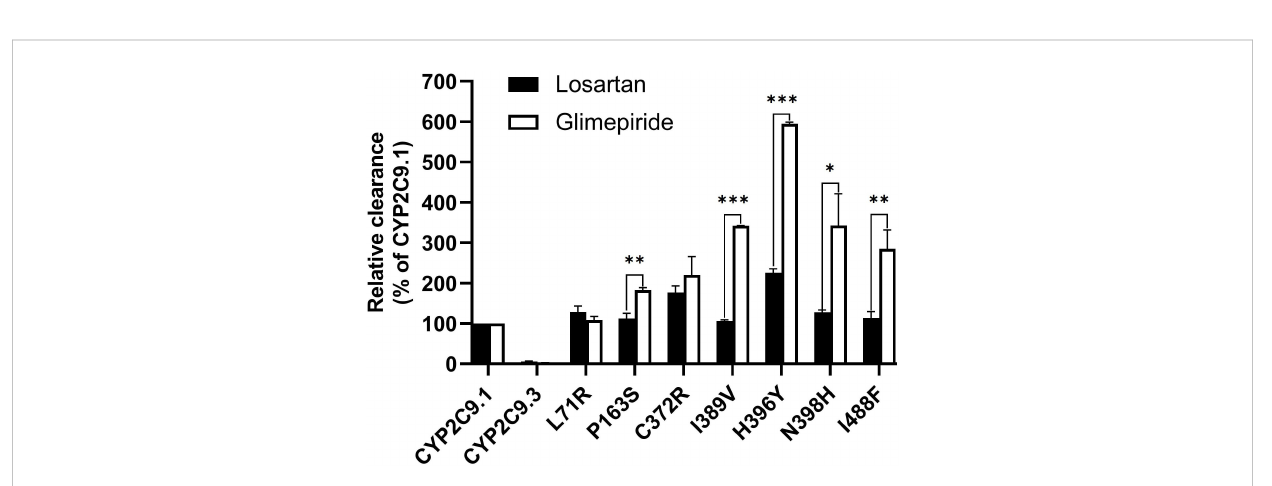
FIGURE 5 The relative clearance rates of losartan and glimepiride among wild type CYP2C9.1, typical defective variant CYP2C9.3 and 7 newly detected variants. * P < 0.05, ** P < 0.01, and *** P <